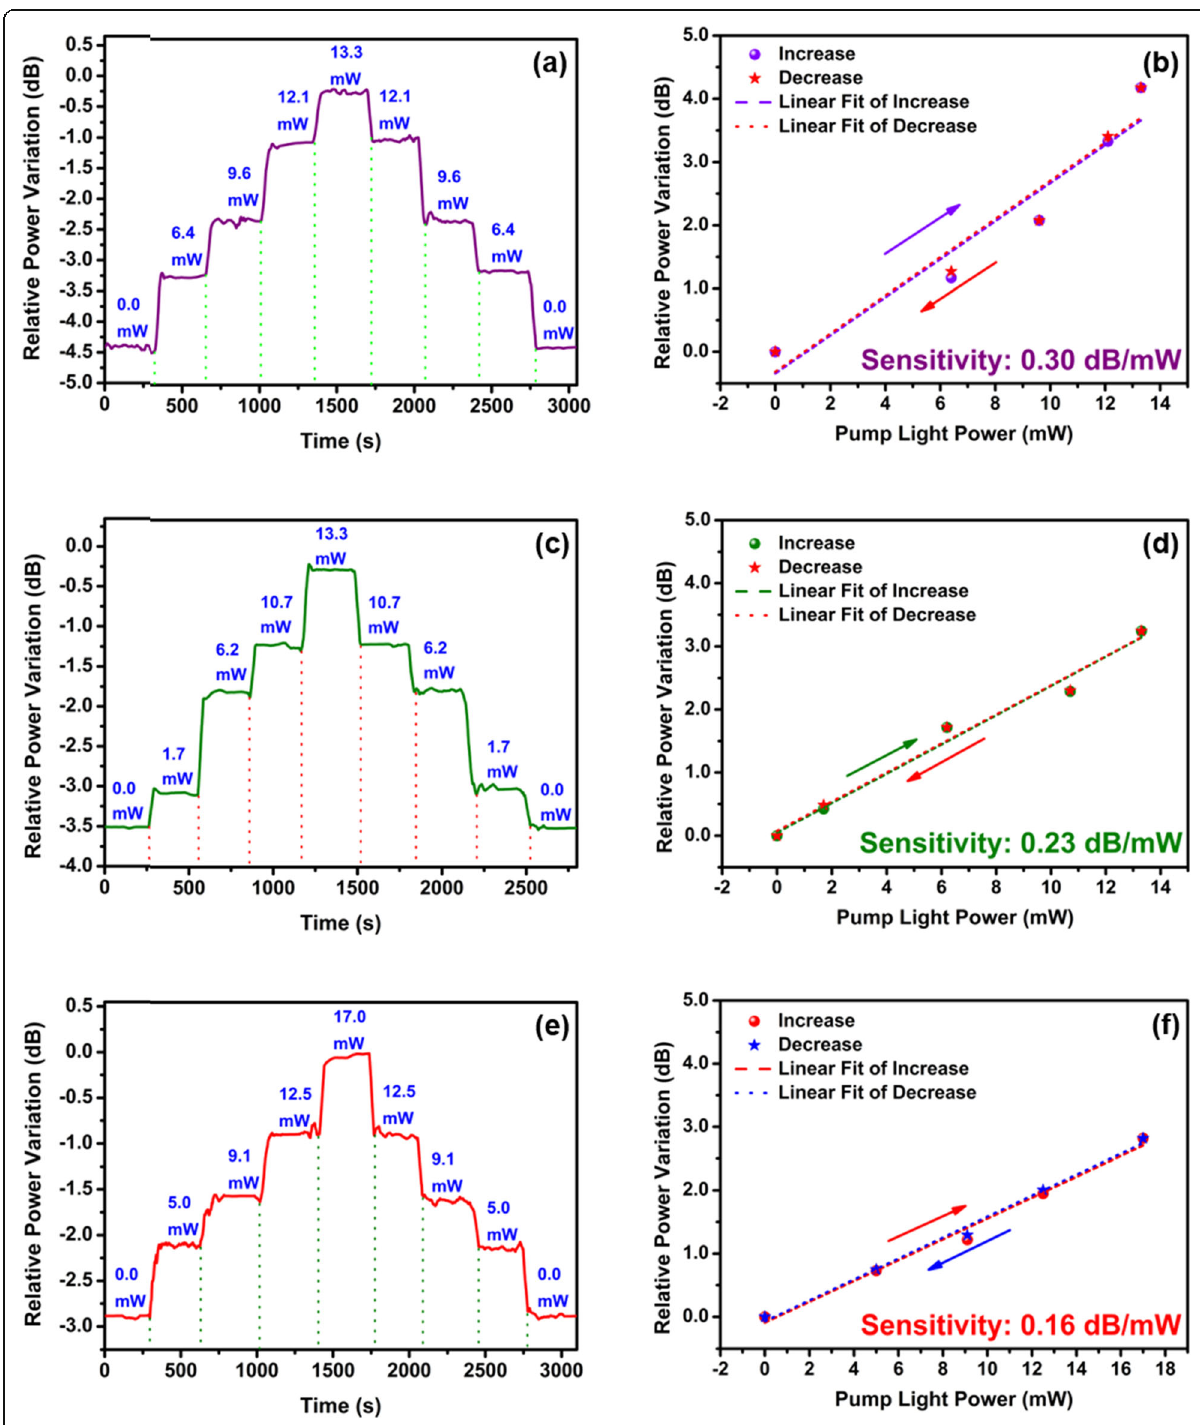
Fig. 8 a TOP variation under different 405-nm laser power. b TOP variation versus 405-nm pump light power. c TOP variation under different 532-nm laser power. d TOP variation versus 532-nm pump light power. e TOP variation under different 660-nm laser power. f TOP variation versus 660-nm pump light